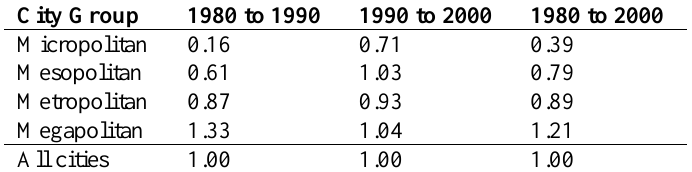
Table 1. Population change by city classification City